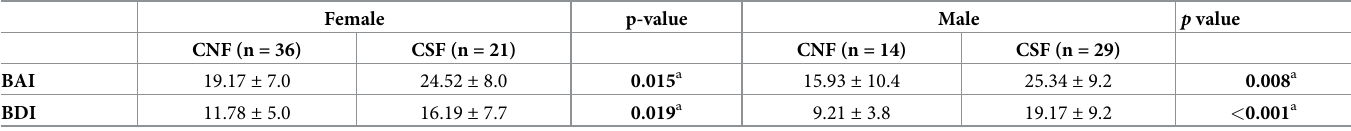
study examined gender differences in depression (using the BDI score) and revealed that the